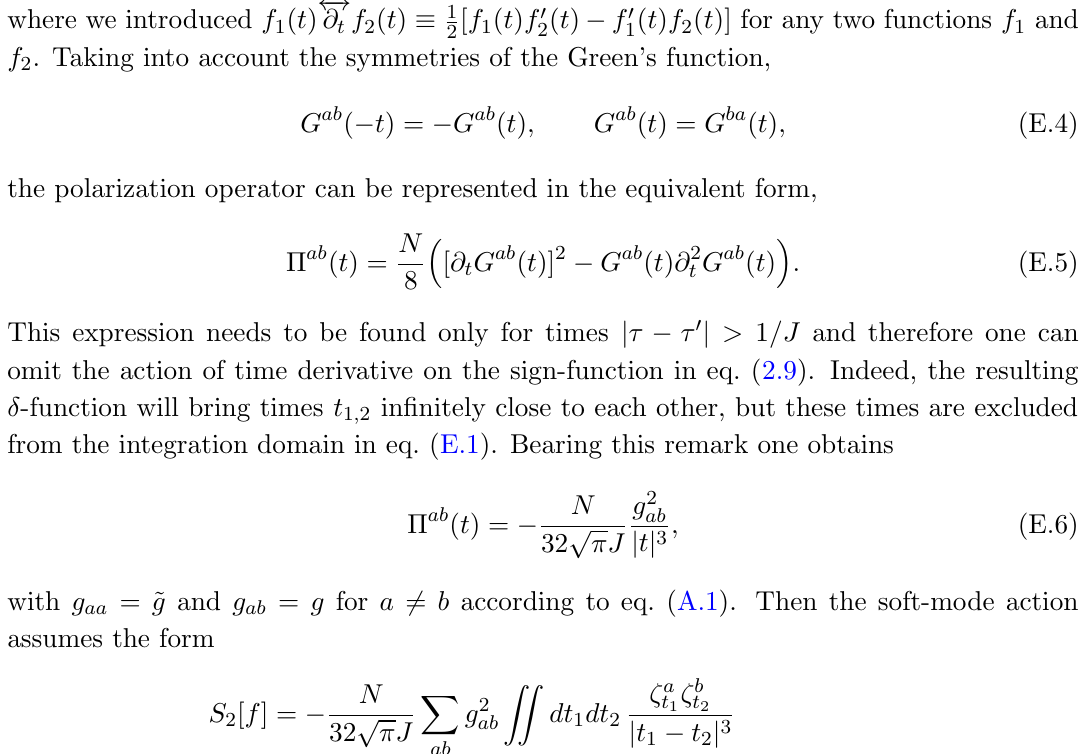
Figure 6 . The curve C is de(cid:12)ned by the relation f a ( (cid:28) coordinates ( (cid:28); s ) is chosen as described in the main text so that (cid:28) runs along C and s in the orthogonal direction. The main contribution to the action (E.7) stems from the region j s j . 1 =J